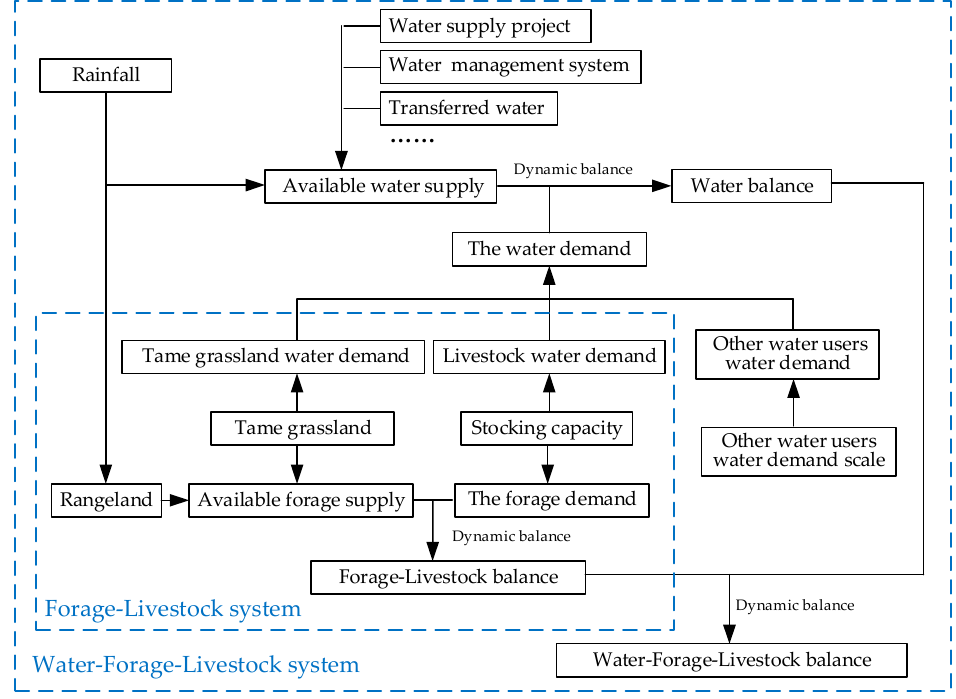
Figure 2. Schematic diagram of the water, forage, and livestock balance system.